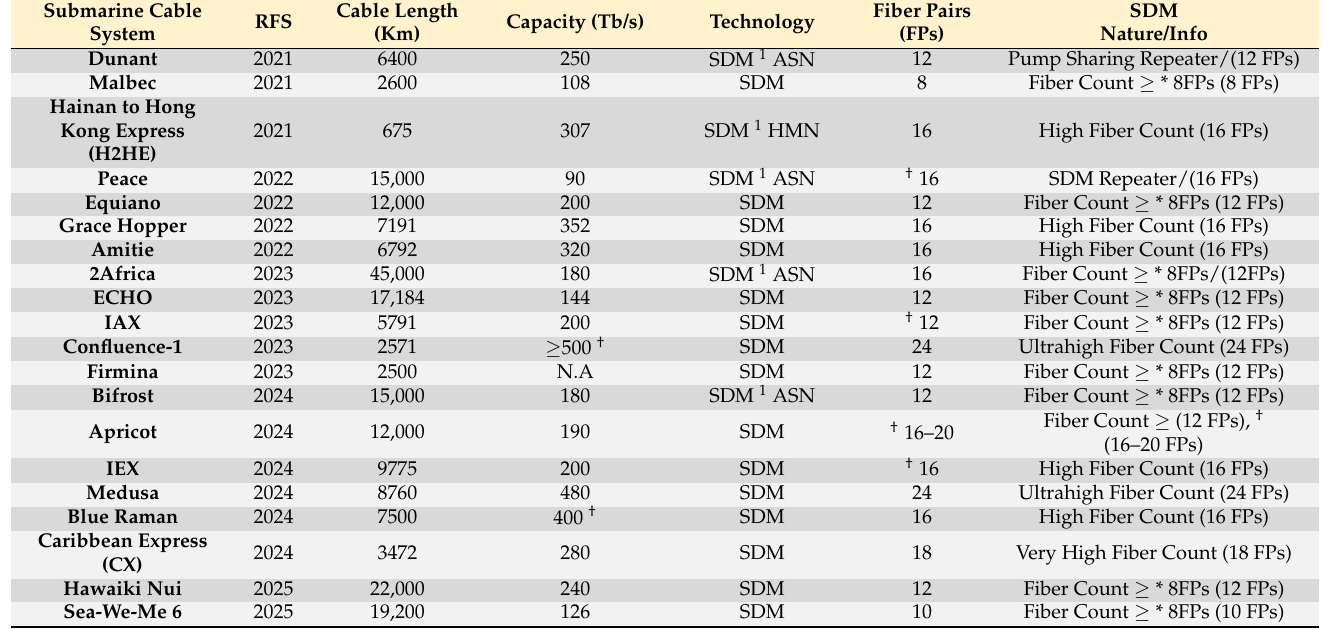
Table 3. A taxonomy of SDM-based submarine cable systems [1–5]. RFS: Ready for Service year, SDM 1 : First Generation of SDM-based system introduced by (ASN/HMN)